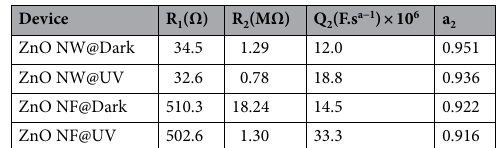
Table 2. Parameters of the equivalent circuit model, derived from fitting to EIS